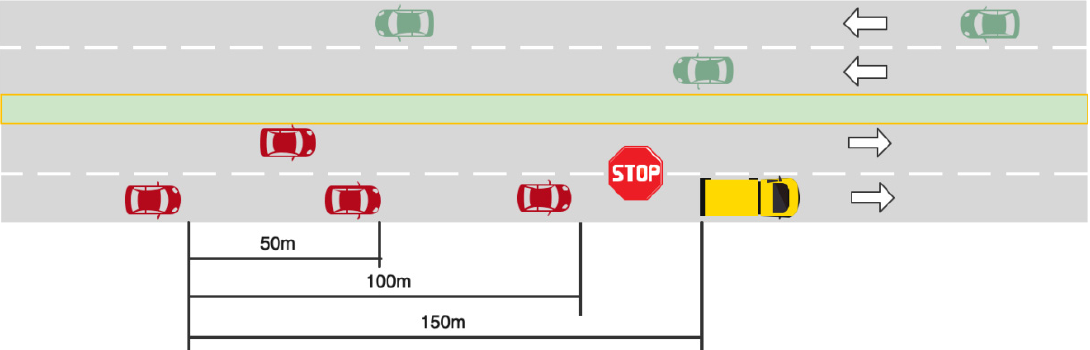
Figure 2. Design of the scenarios.